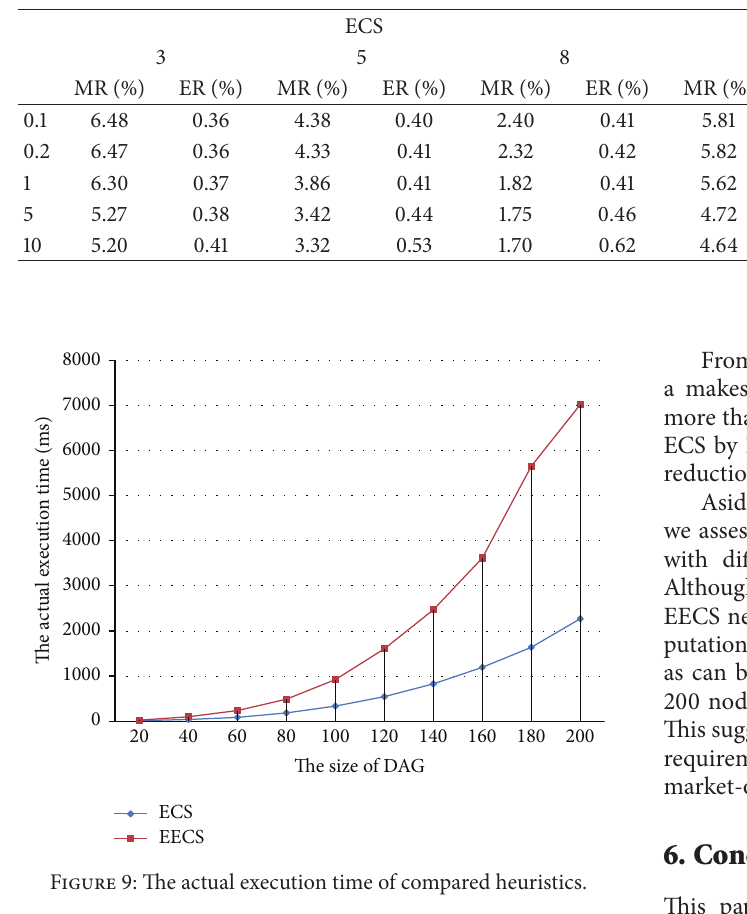
Table 10: Comparative results of Figure 6: LIGO, 77 nodes (different sizes of processors).